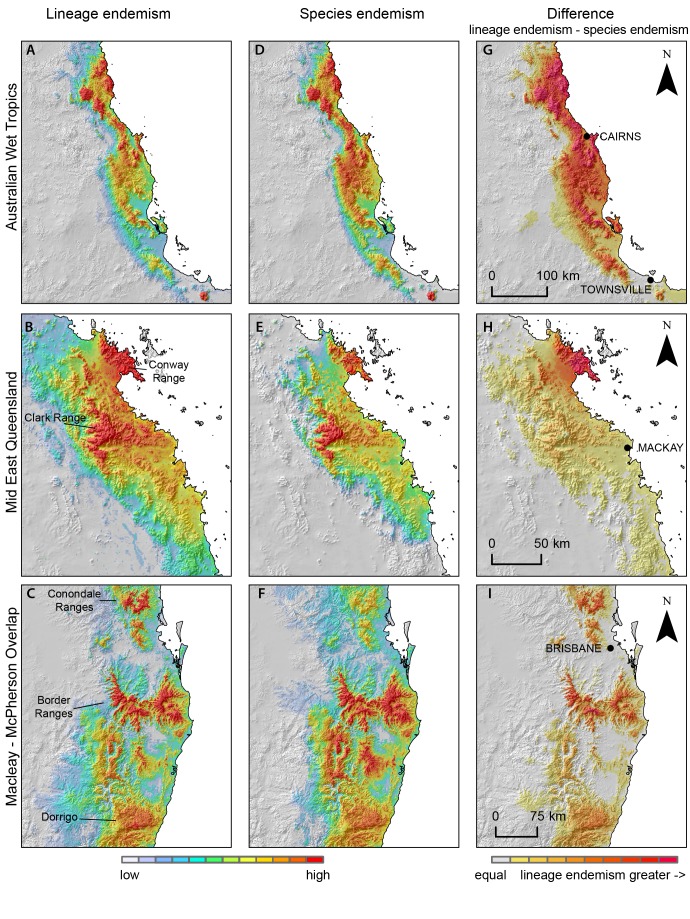
Lineage endemism (left column), species endemism (middle column), and the difference between them (right column), for three areas.Places labelled on panels A-C refer to areas of high endemism. Colours by quantile classes, separately for each panel.